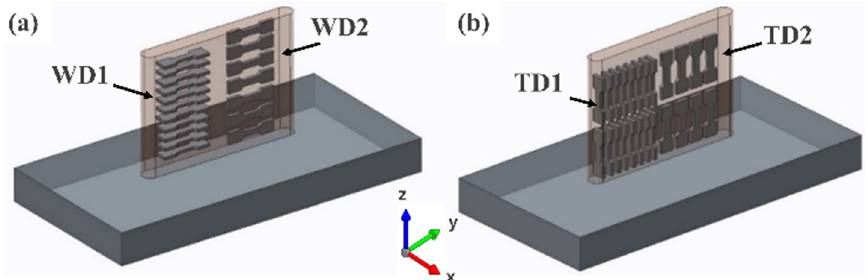
Figure 3. Schematic illustration of tensile strength test specimen location; ( a ) welding direction (x-y axis), ( b ) transverse direction (x-z axis). Table 2. Deposition parameter of the experiment.